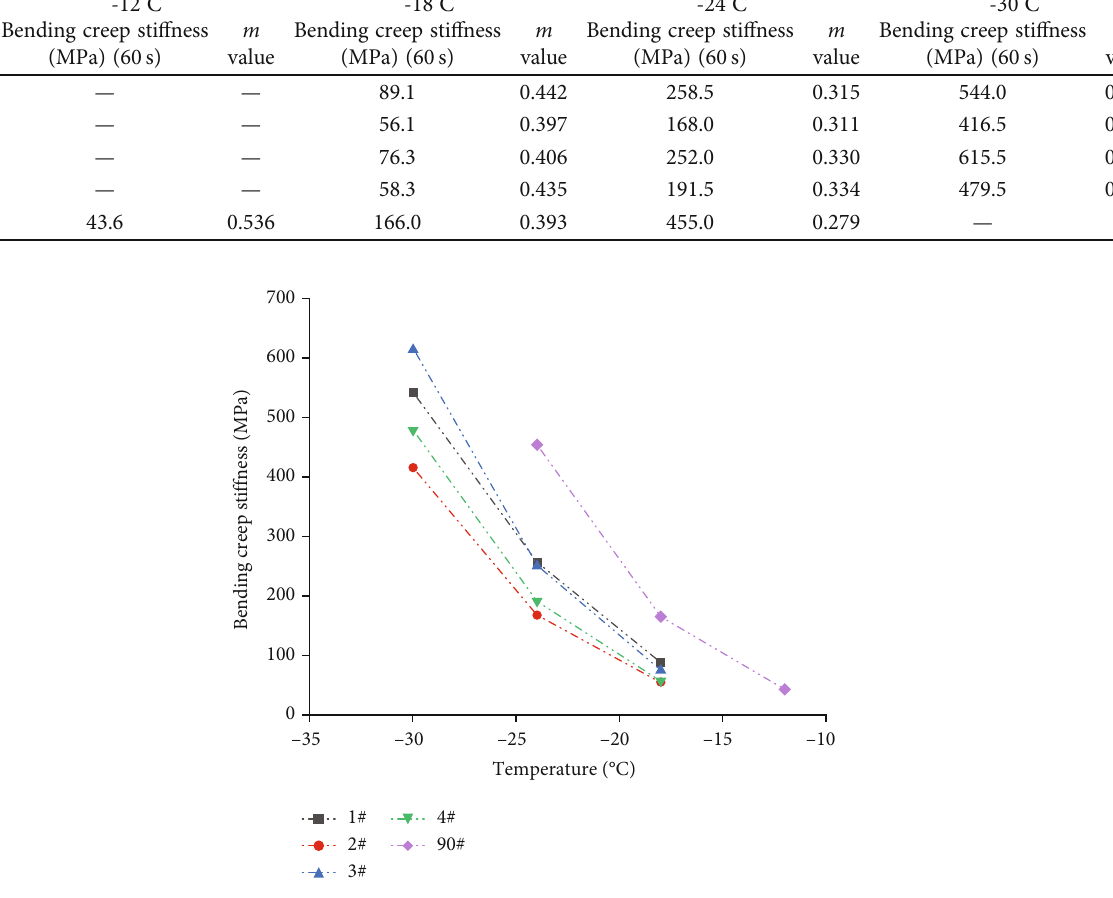
Figure 10: Flexural creep sti ff ness curve of tire rubber powder-modi fi ed asphalt.